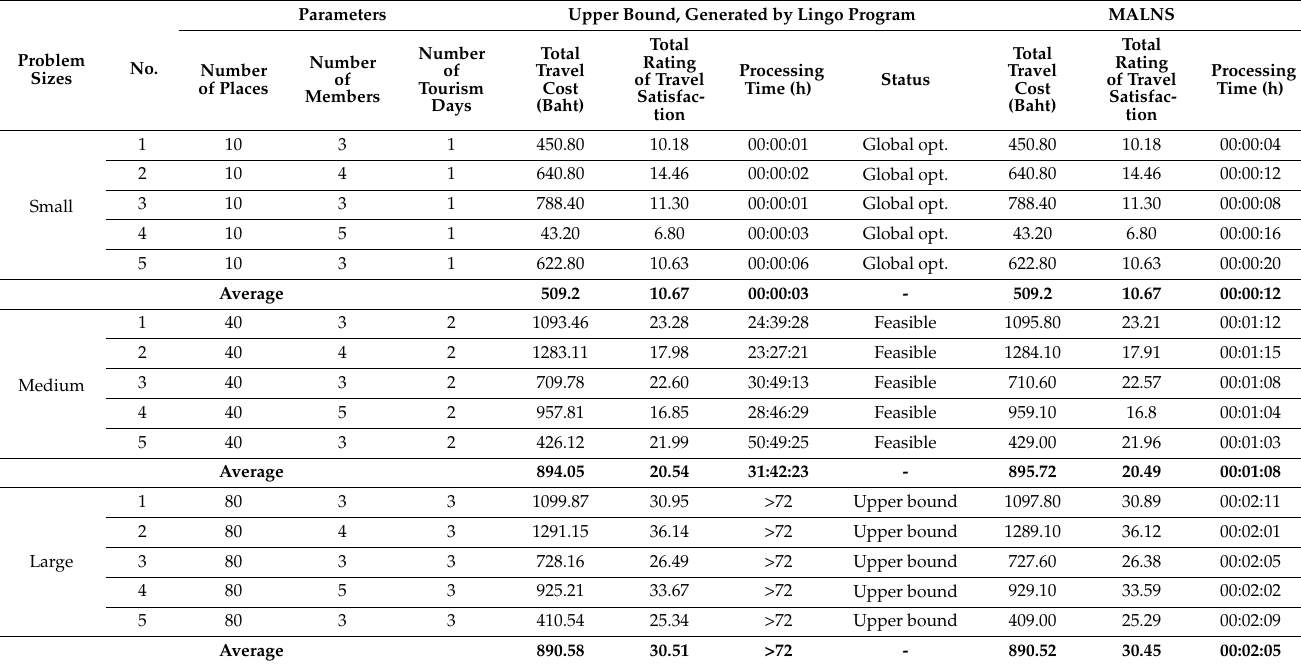
Table 2. The comparison results for the Lingo program and the modified adaptive large neighborhood search (MALNS) algorithm.